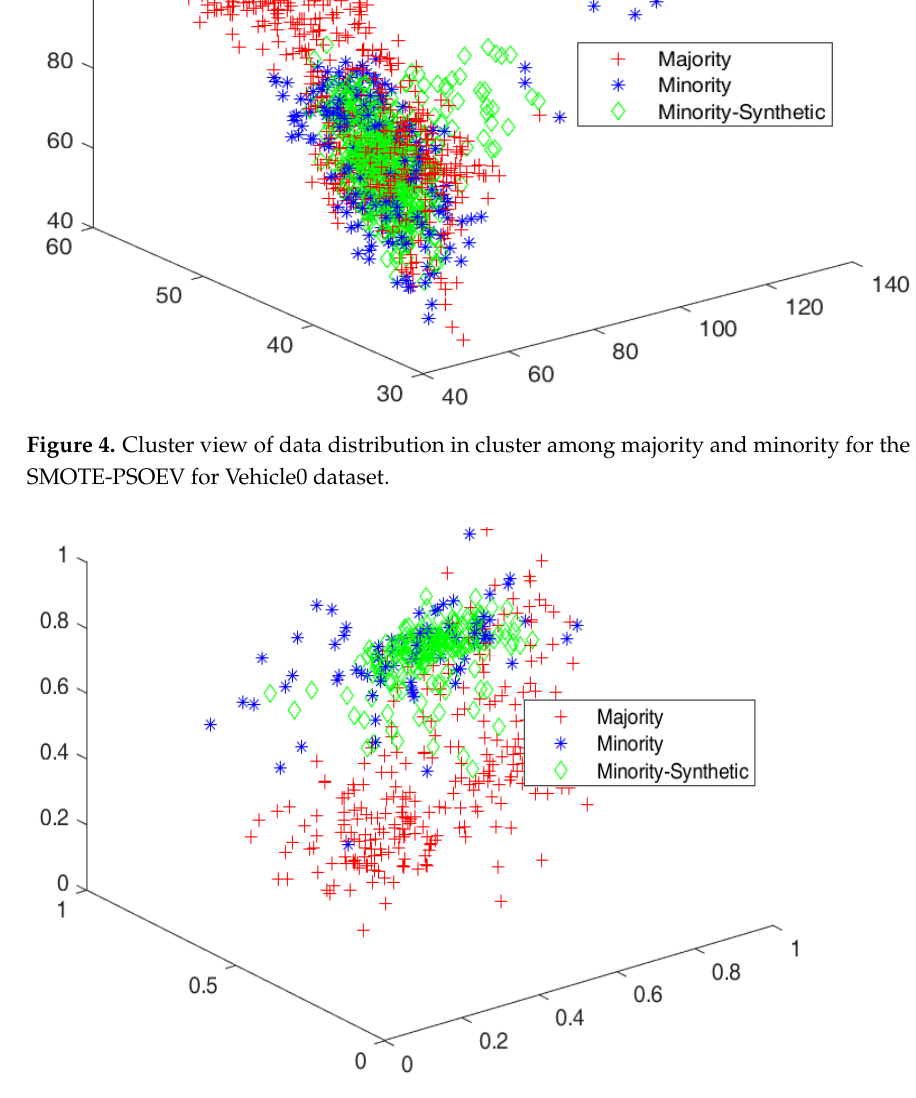
Figure 5. Cluster view of data distribution in cluster among majority and minority for the proposed SMOTE-PSOEV for Ecoli1 dataset.